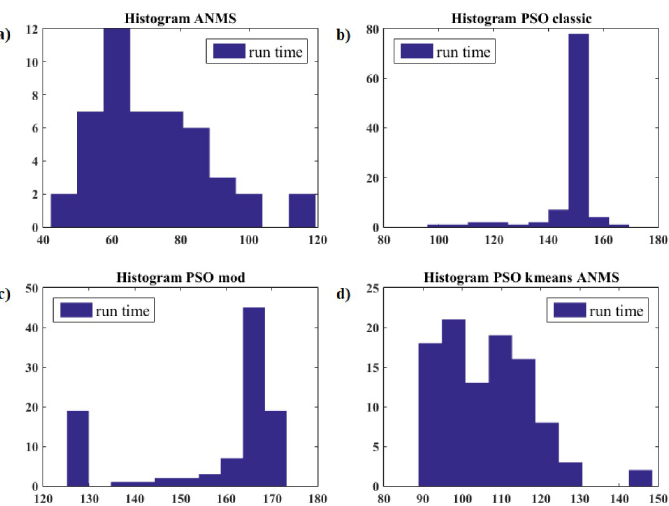
Fig 23. Case 1 (100 × 20). Histograms of the CPU time spent by the four optimization algorithms, ANMS, PSO classic, PSO mod, and PSO-Kmeans-ANMS, respectively. Only applied to successful